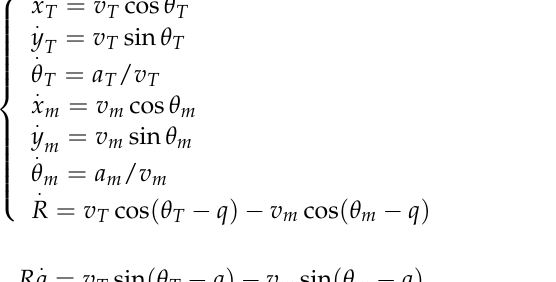
Figure 3. Dynamics of the missile in the pitch plane. As can be seen in Figure 3, which gives a schematic of the missile in the pitch plane. X and Y denote the aerodynamic drag and the lift force of M denotes gravity. aero aero g α represents the attack angle. the missile, respectively. In addition, According to all the conditions above, when assuming 0, equations of the missile-target can be written as follows: